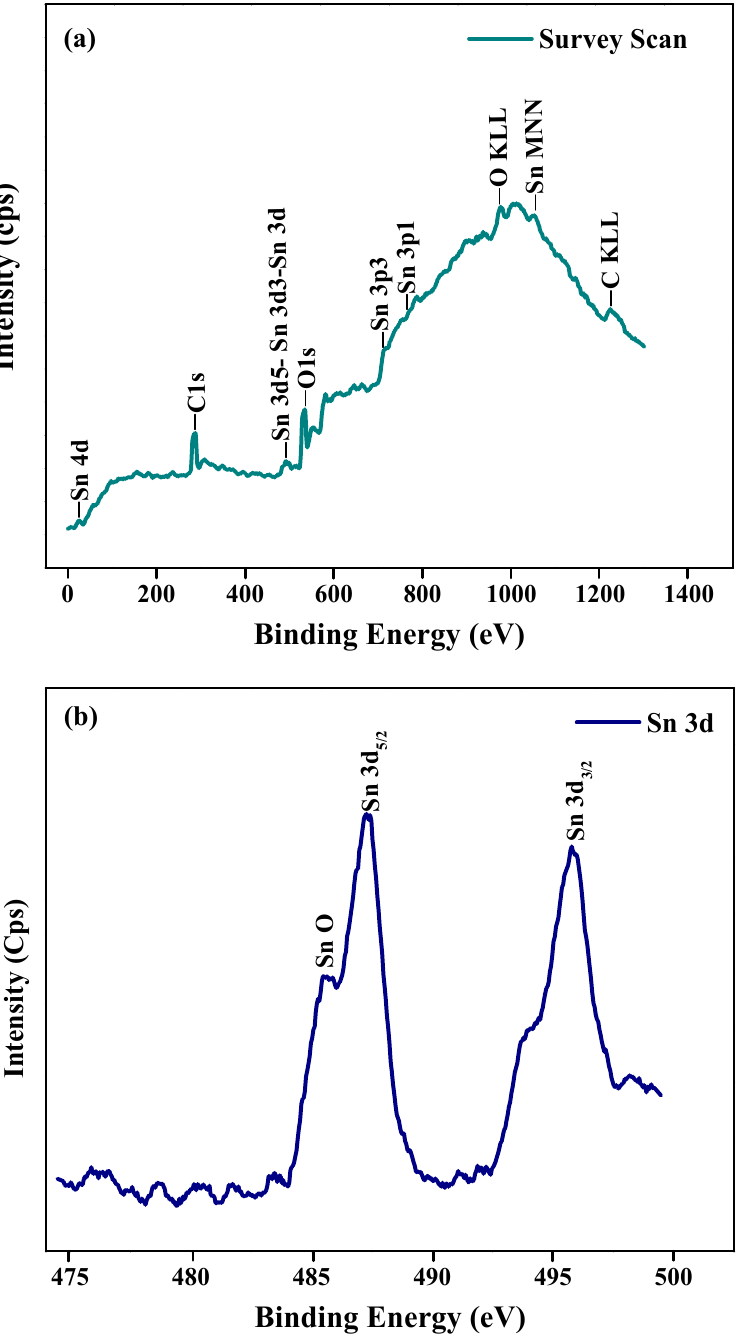
Figure 3. X-ray photoelectron spectroscopy (XPS) spectra of SnNPs surface: ( a ) survey scan and ( b ) high-resolution spectra of Sn 3d.